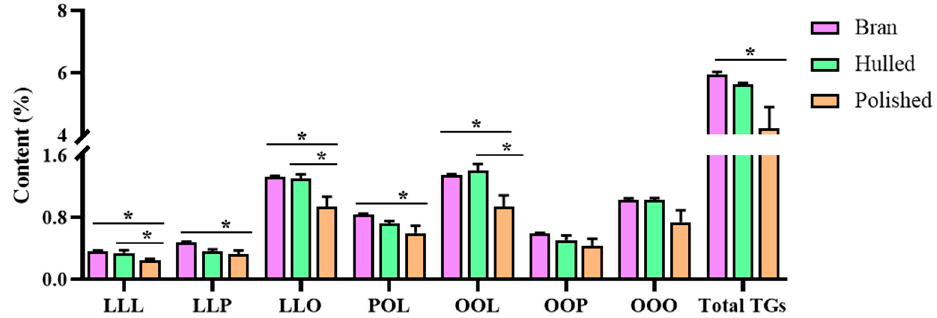
Figure 4. Contents of triglycerides from the hulled, polished coix seed and the bran, * p < 0.05.